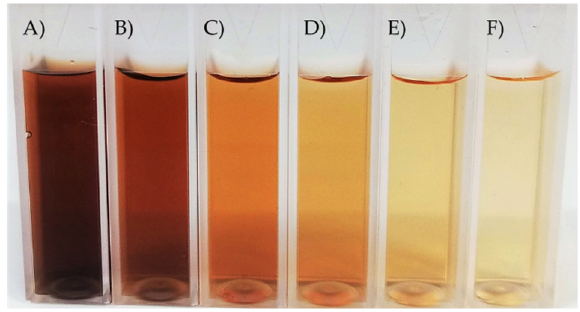
Figure 1. Comparison of the color intensity of eumelanin after treatment with LMCS at 24 h: ( A ) Sepia melanin as reference; ( B ) LMCS As/V; ( C ) LMCS TEMPO/V; ( D ) LMCS Syr/V; ( E ) LMCS ABTS/V; F ) LMCS V/Va.